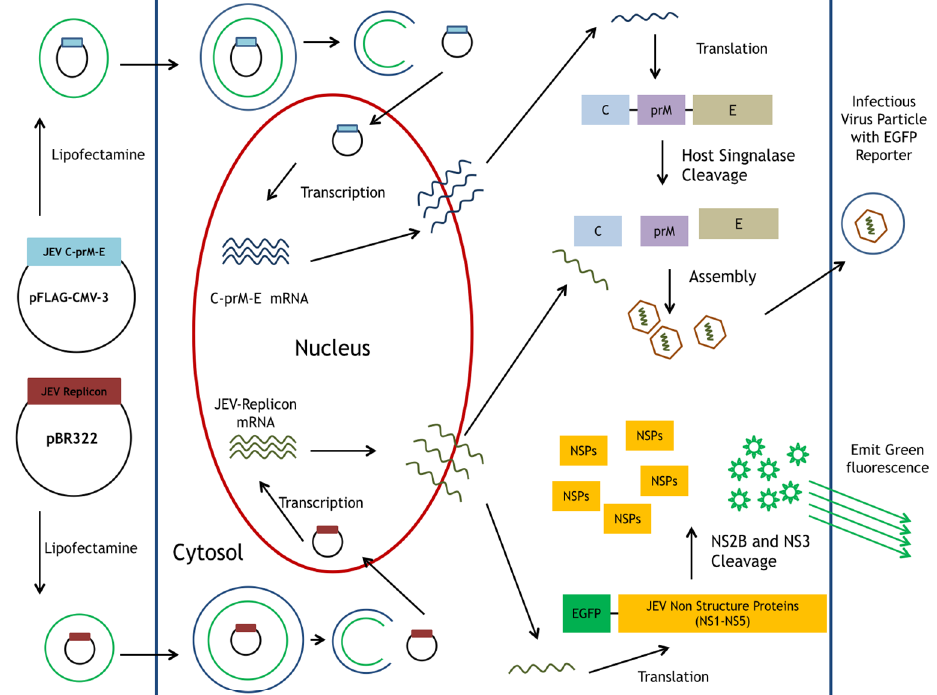
Figure 1. Schematic diagram of the production for JEV ‐ EGFP SRIPs in pBR322 ‐ based JEV replicon ‐ transfected packaging cells expressing JEV structural proteins. A reporter gene EGFP was the functional marker for the replication of replicon and SRIP in